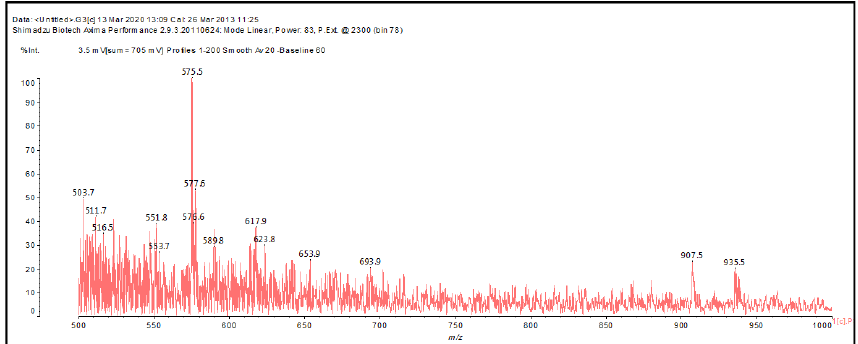
Figure 2. MALDI ToF spectrum of humins obtained at 150 °C from fructose, 20 – 500 Da range.